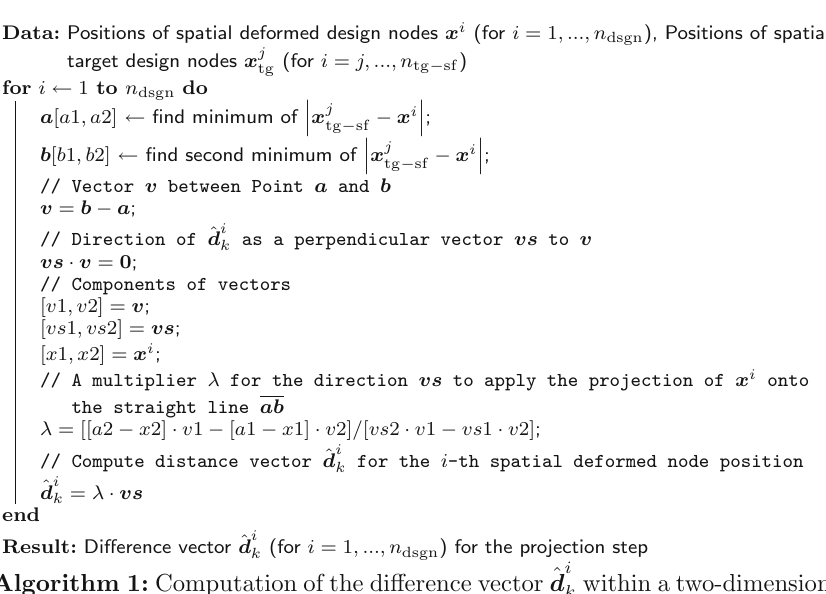
Algorithm 1: Computation of the difference vector ˆ d